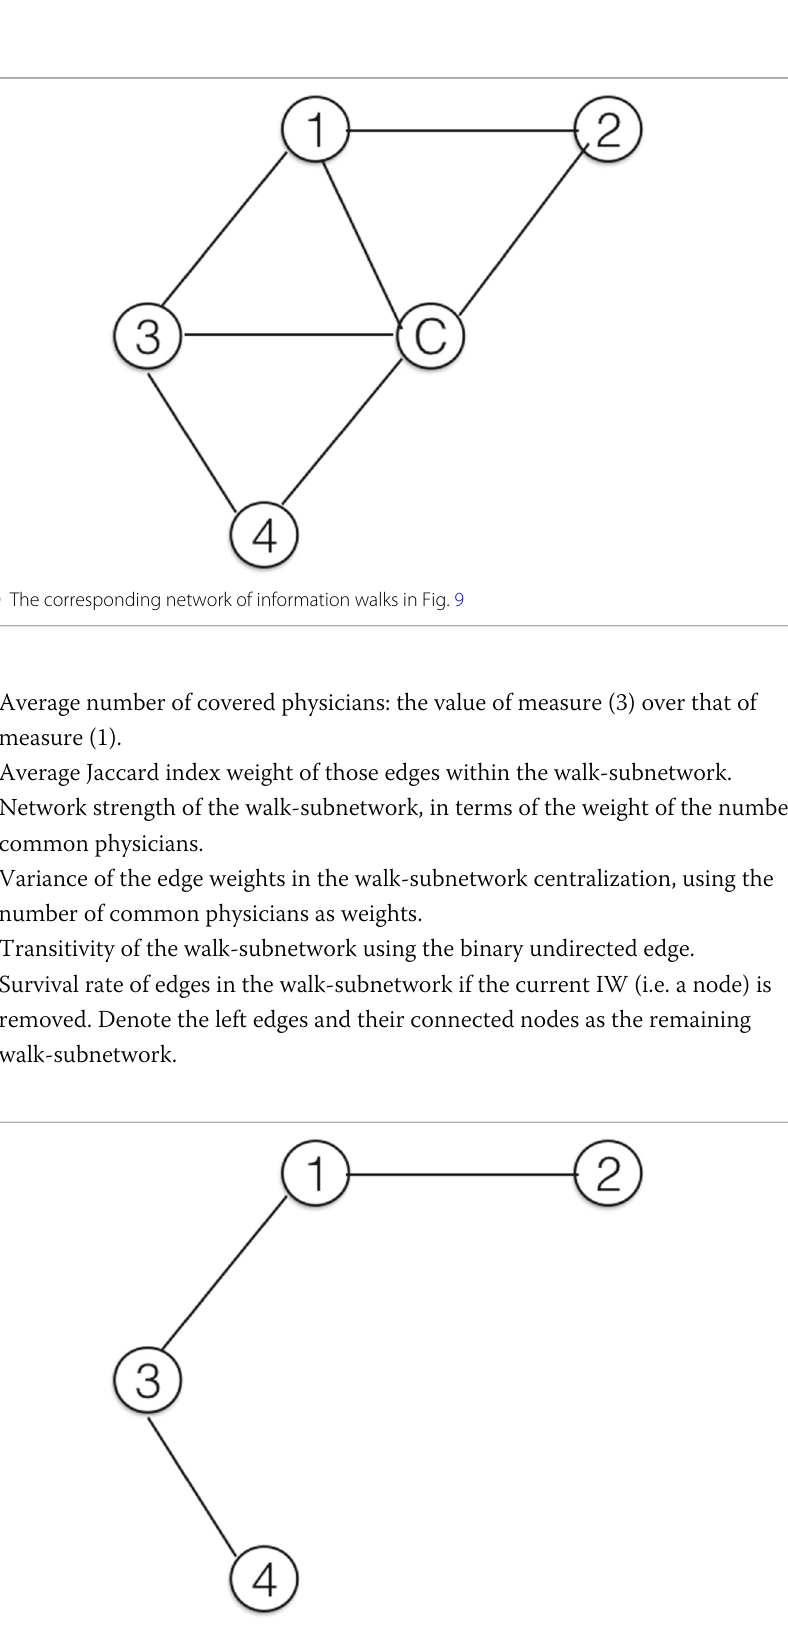
Fig. 11 The remaining walk-subnetwork after dropping the current walk (C-IW) from the information walks network in Fig.